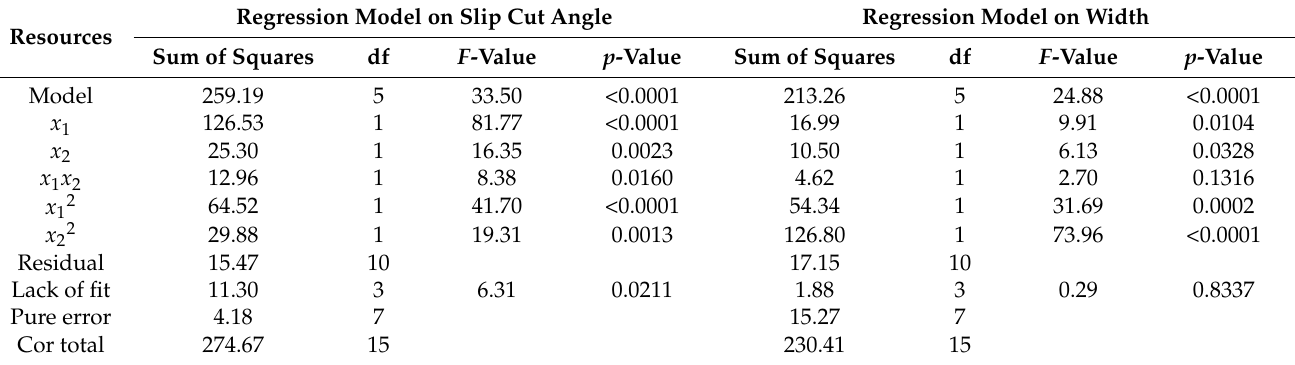
Table 2. Optimization model of test